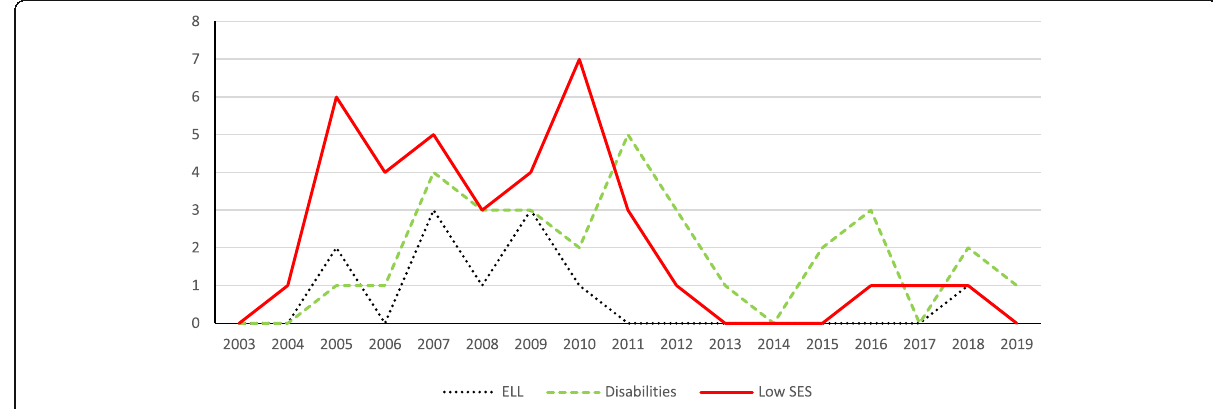
Fig. 14 The distribution of projects in STEM education for special participant populations over the years